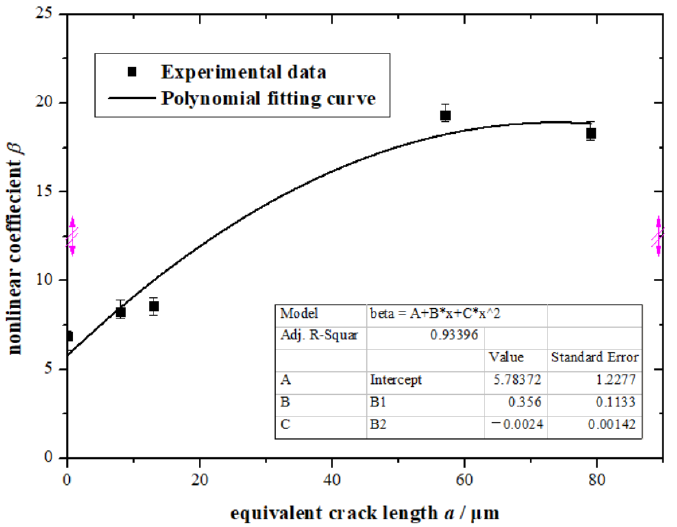
Figure 12. Relationship between equivalent crack length and nonlinear coefficient of the KMN vibration fatigue specimens.